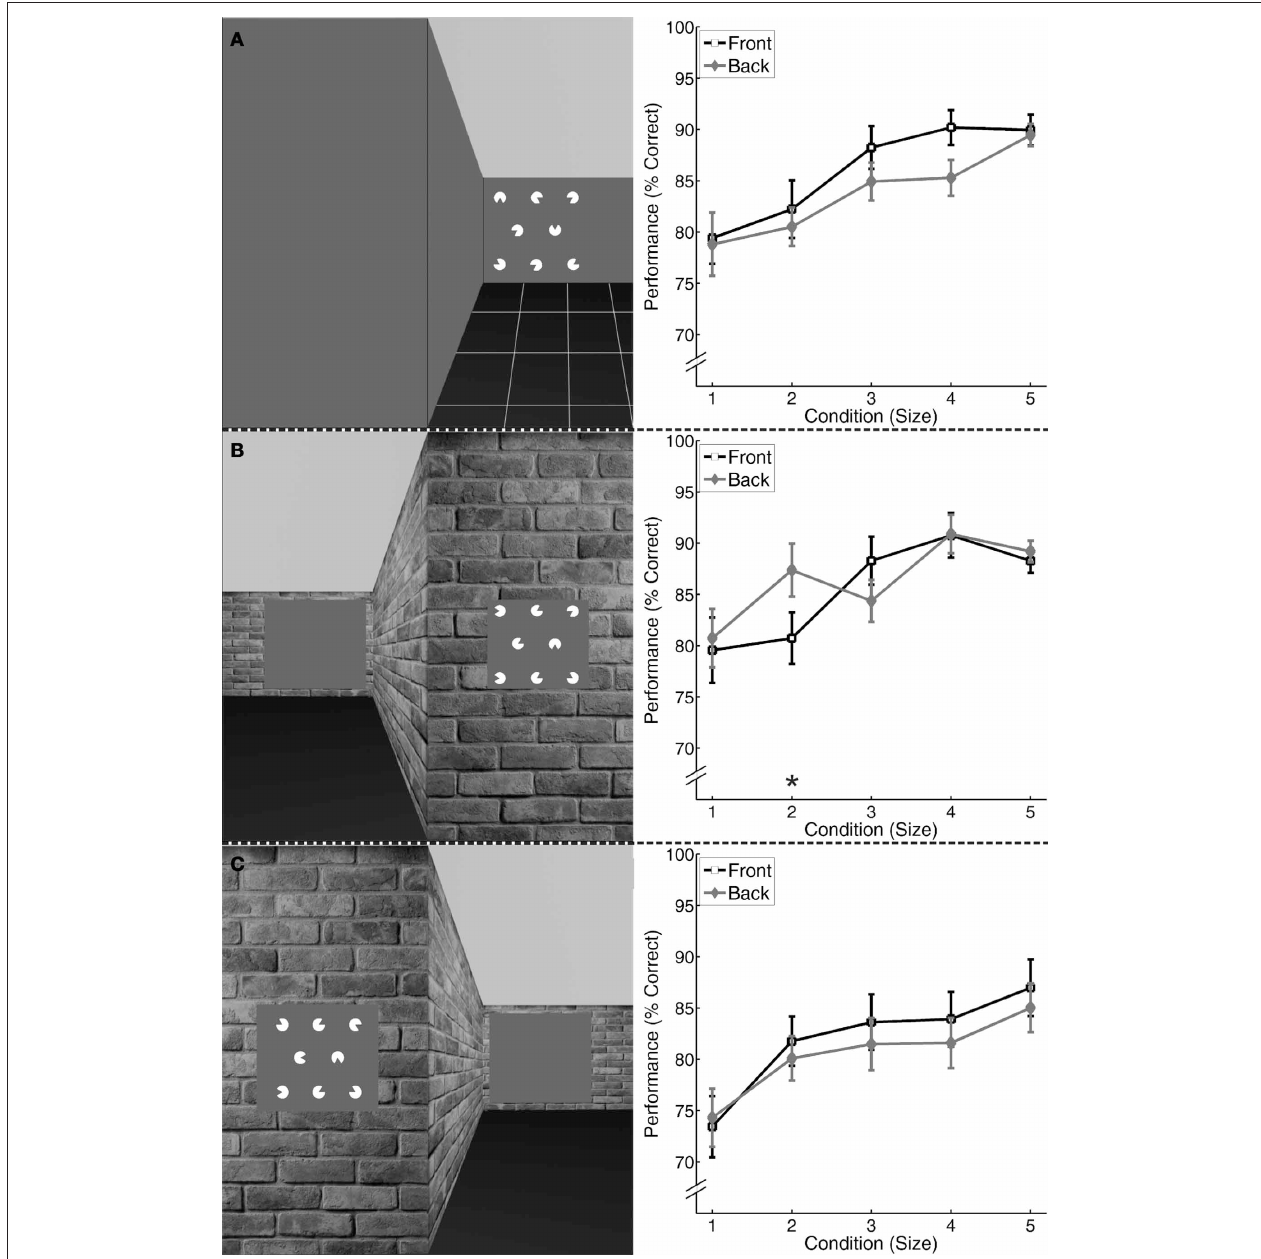
FIGURE 3 | Left: 3-2-3 array of white “pacmen” forming a “Kanizsa” triangle in one of four possible positions presented on one side of a shifted wall. (A) Stimulus for Experiment 3: 3-2-3 array presented on a uniform gray wall; (B) Stimulus for Experiment 4: 3-2-3 array presented on a gray box within a naturalistic wall. (C) Sample Stimulus for Experiment 5: 3-2-3 array presented on a size adjusted gray box within a